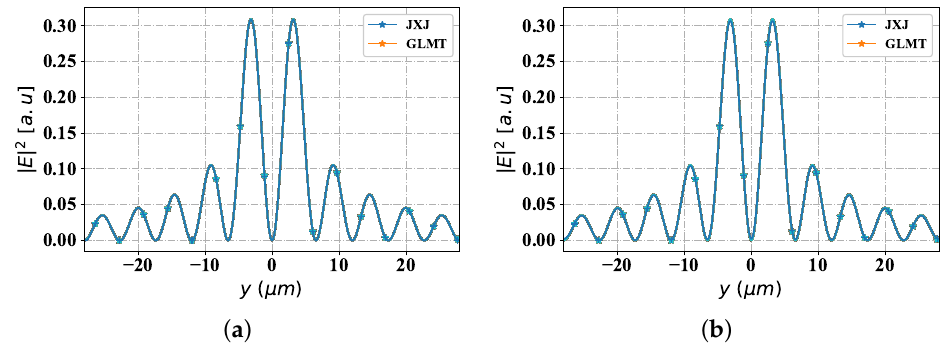
Figure 2. Validation of different | E | 2 with GLMT, and JXJ. ( a ) TE ; ( b ) TM